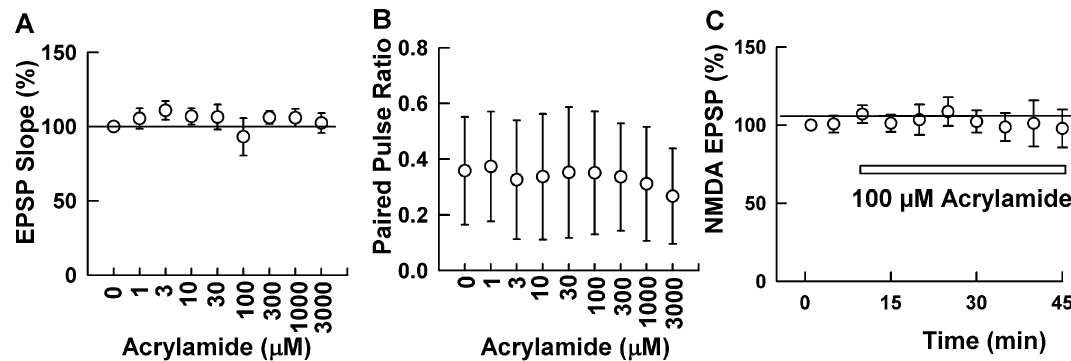
Figure 1. ACR does not alter basal synaptic transmission in the CA1 region of hippocampal slices. ( A ) In 5 slices, the concentration of ACR was raised step by step every 15 min. EPSPs, evoked by stimulation of the Schaffer collateral pathway, were not altered by ACR up to 3 mM. ( B ) Similarly, paired pulse depression normally observed at 21 ms was not altered by ACR up to 3 mM. ( C ) In different slices, NMDAR-mediated synaptic responses recorded in low magnesium were not altered by 100 μM